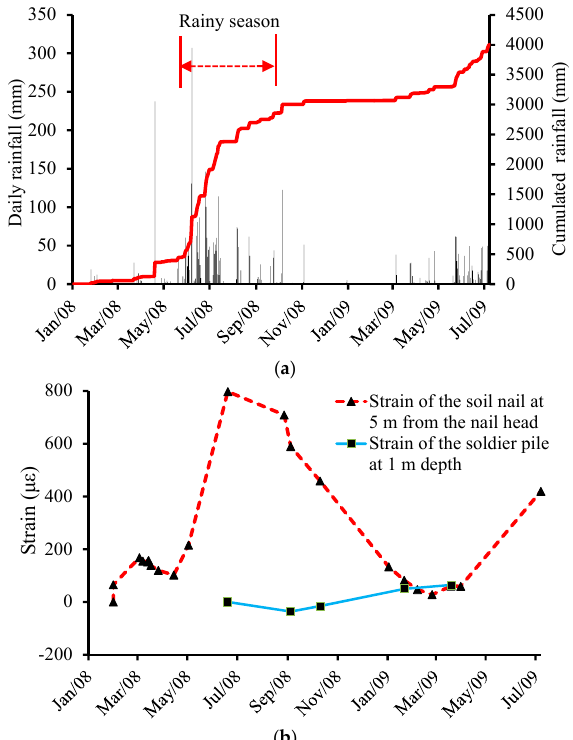
Figure 7. Long-term monitoring results of the slope site in Hong Kong (adapted from [15]). ( a ) Rainfall; ( b ) Strains of the soil nail and the soldier pile.